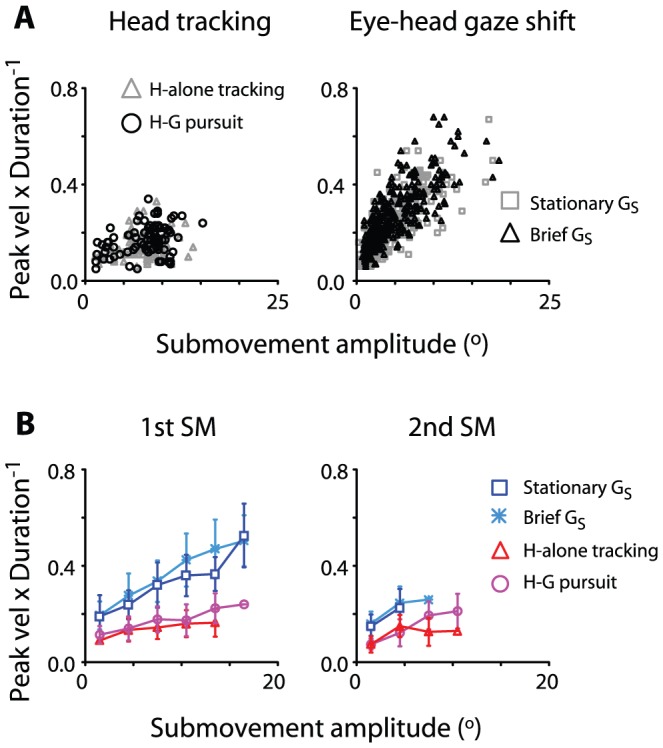
Head tracking movements and eye-head combined gaze shifts distinguished by normalized peak velocity (peak velocity×duration−1) as a function of submovement amplitude.Peak velocity and duration are computed after the example shown in Figure 6. Data is plotted as mean ± S.D. Note the submovements exhibited relatively higher normalized peak velocity during eye-head combined gaze shifts compared to head tracking movement. This tendency persisted independent of movement amplitude and the order of the submovements.